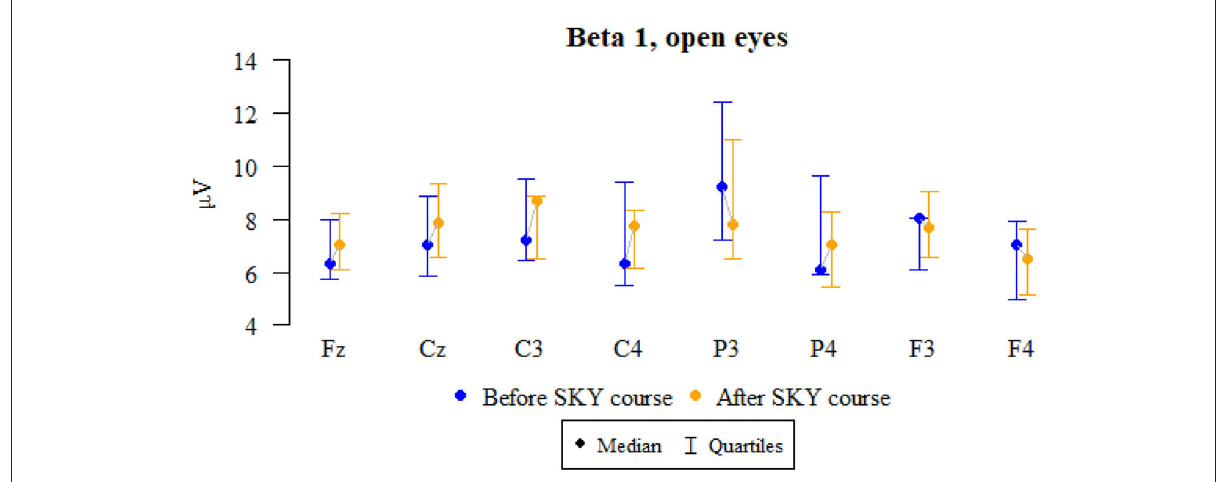
FIGURE3 Graphical comparison of Beta 1 wave amplitudes before the SKY course (first day) and after the whole SKY course (third day) with eyes open.